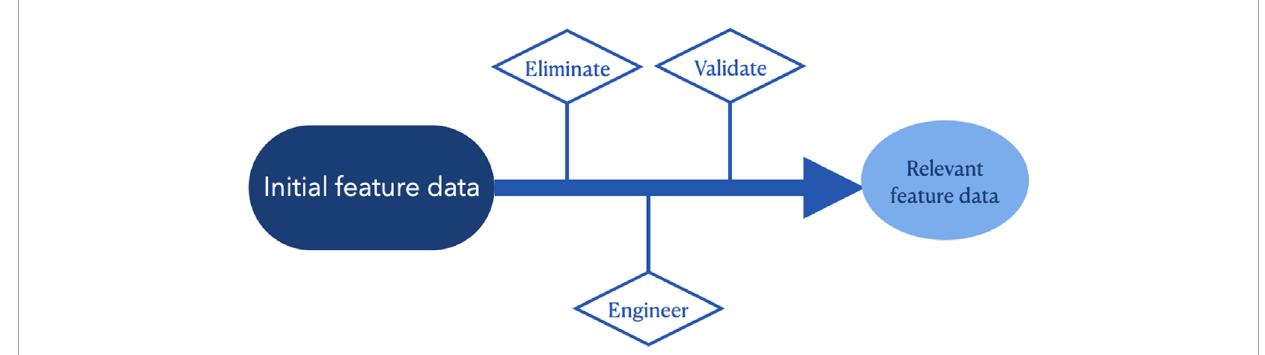
FIGURE 7 Basic steps of feature engineering. From a large amount of initial feature data, the features that are not relevant to the problem are eliminated, the features that are more relevant to the problem are selected, and the subset of features that are most important to the problem is generated.